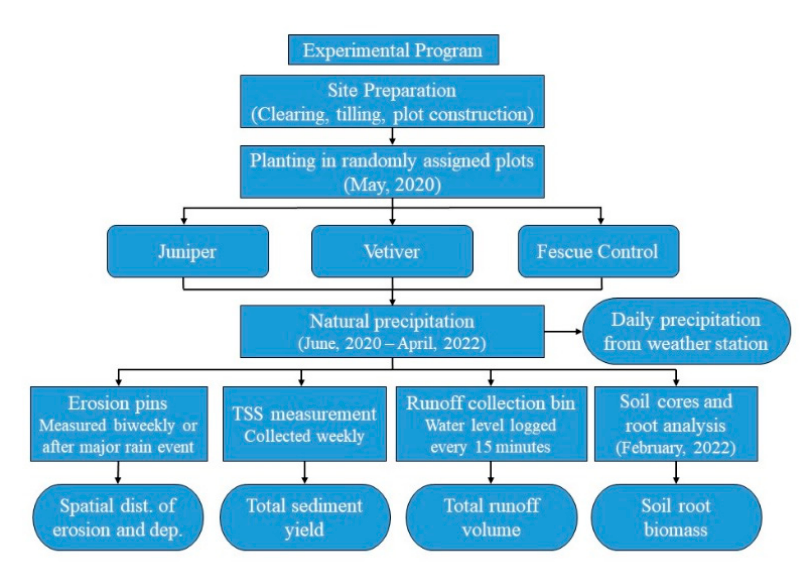
Figure 2. Flow chart illustrating the materials and methods for this study.